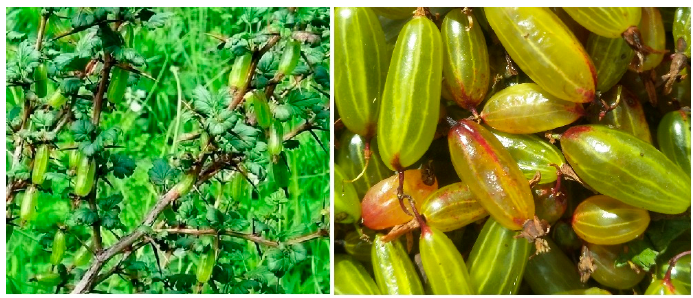
Figure 1. Fruits of Ribes stenocarpum Maxim.